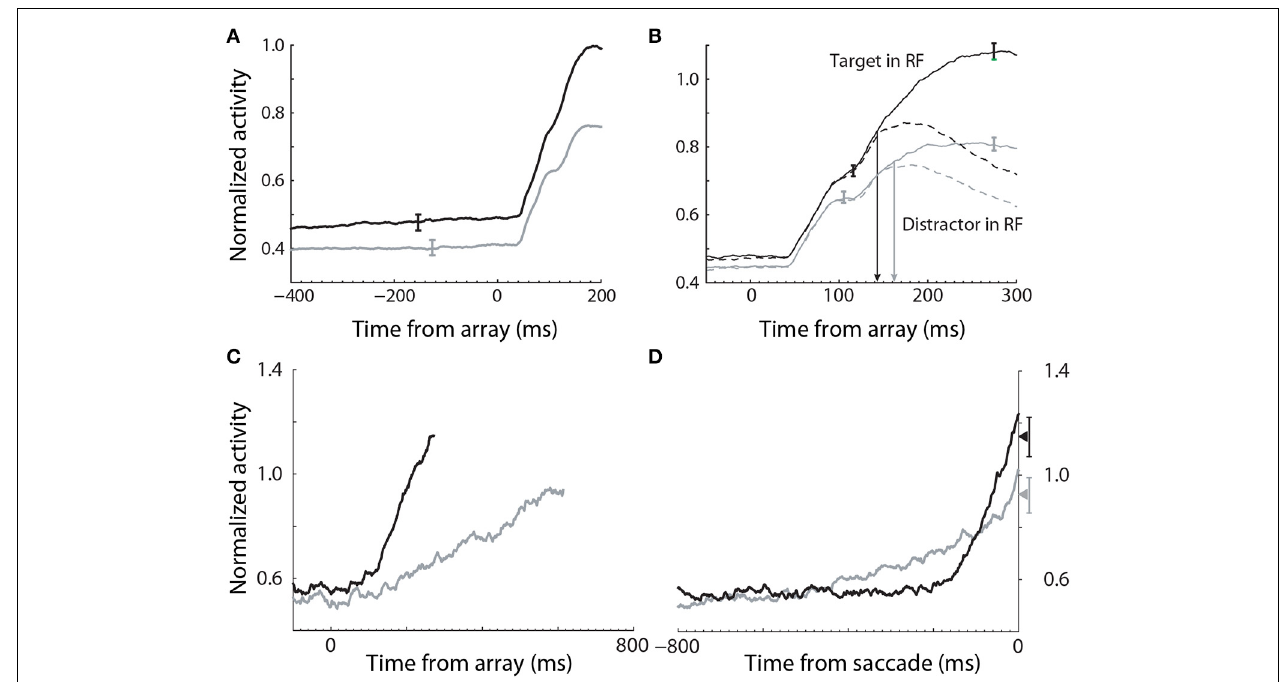
FIGURE 6 | Electrophysiological data recorded from FEF during a visual search task under speed (black) and accuracy (gray) conditions (Heitz and Schall, 2012). (A) The baseline rate of visual (evidence-encoding) neurons was higher and lower under speed and accuracy conditions respectively (stimulus onset at 0ms). (B) The gain of visual neurons was